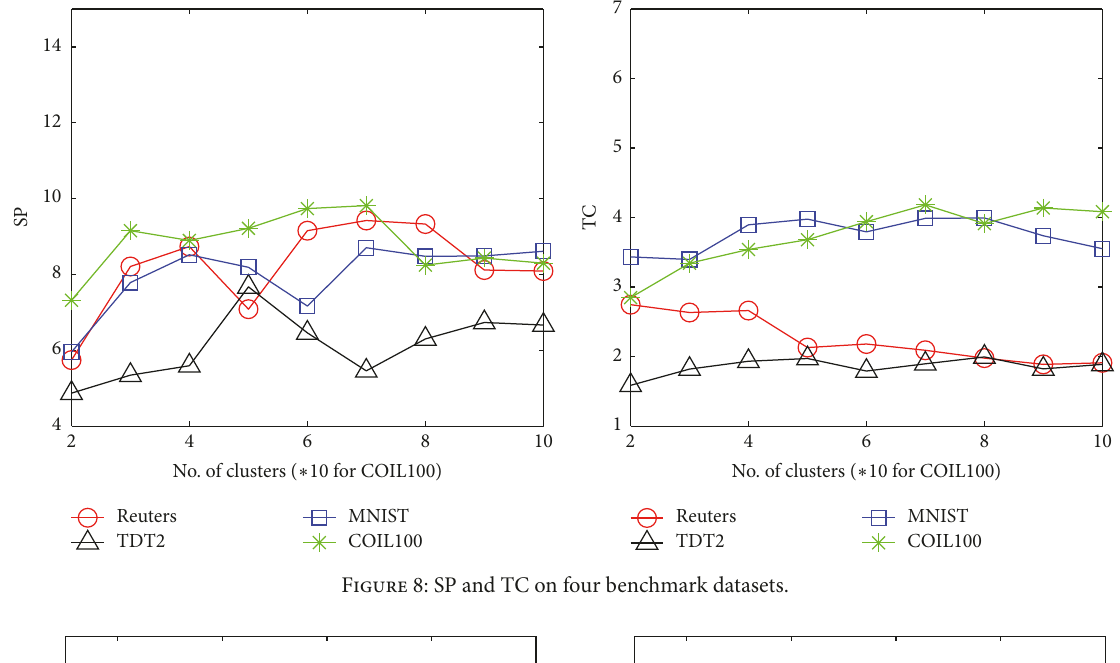
Figure 8: SP and TC on four benchmark datasets.